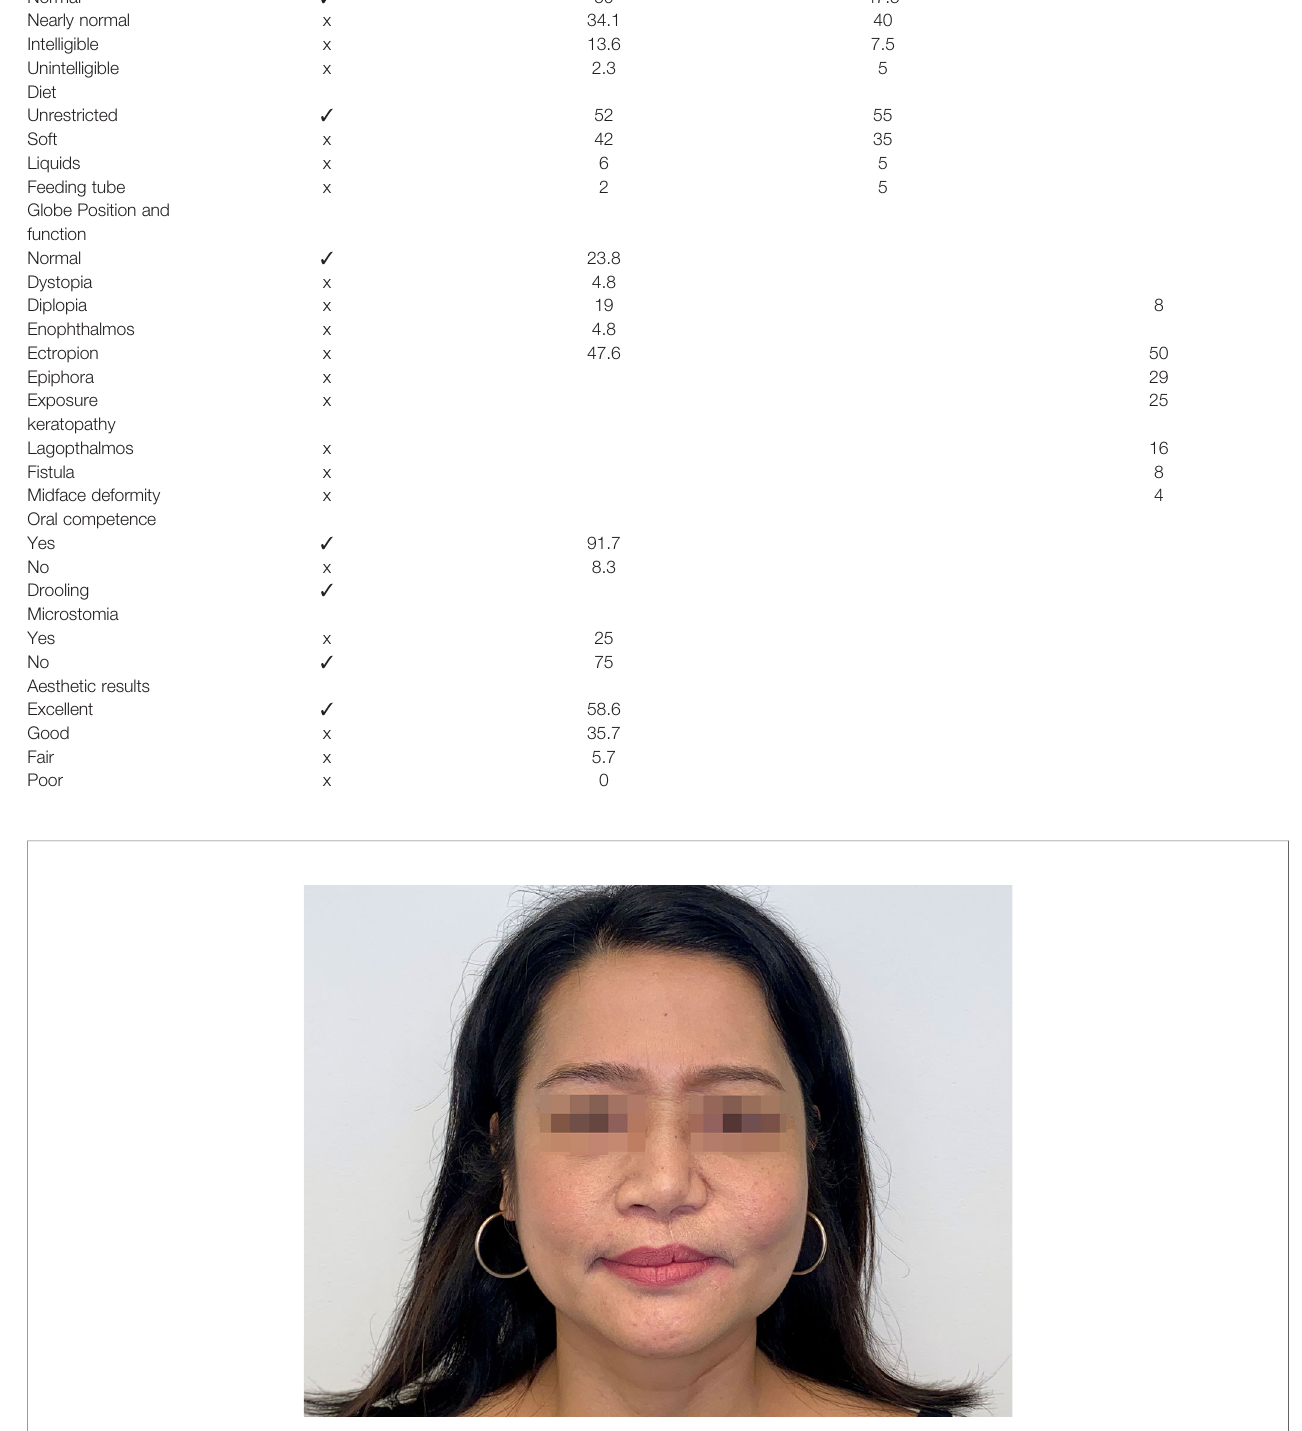
FIGURE 5 | Photographic documentation after reconstruction shows symmetrical and aesthetically pleasing